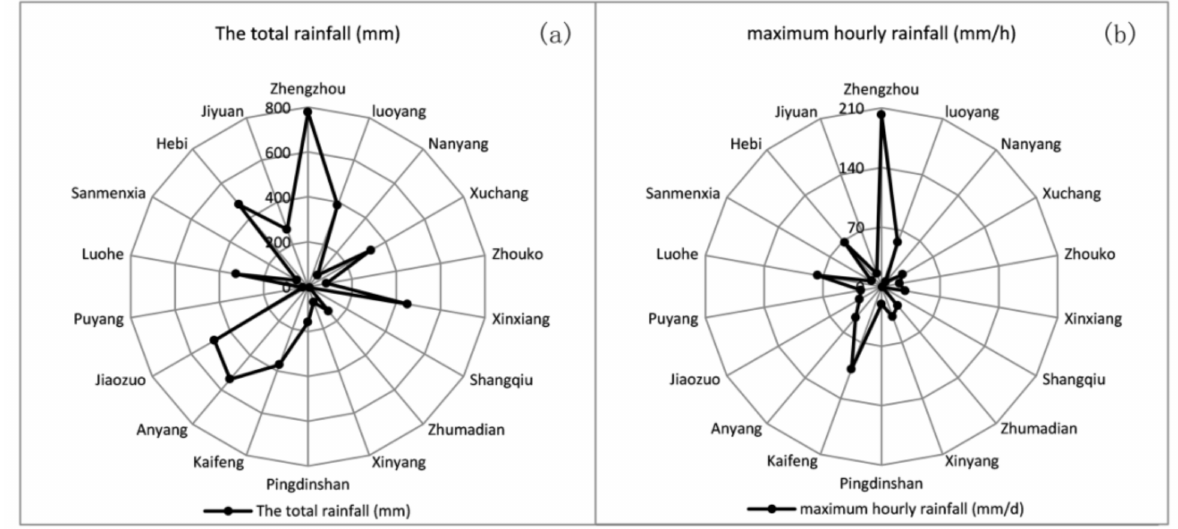
Figure 8. Inversion of rainfall development distribution in Henan Province from 19 July to 22 July: ( a ) Statistical distribution of total rainfall; ( b ) Statistical distribution of hourly maximum